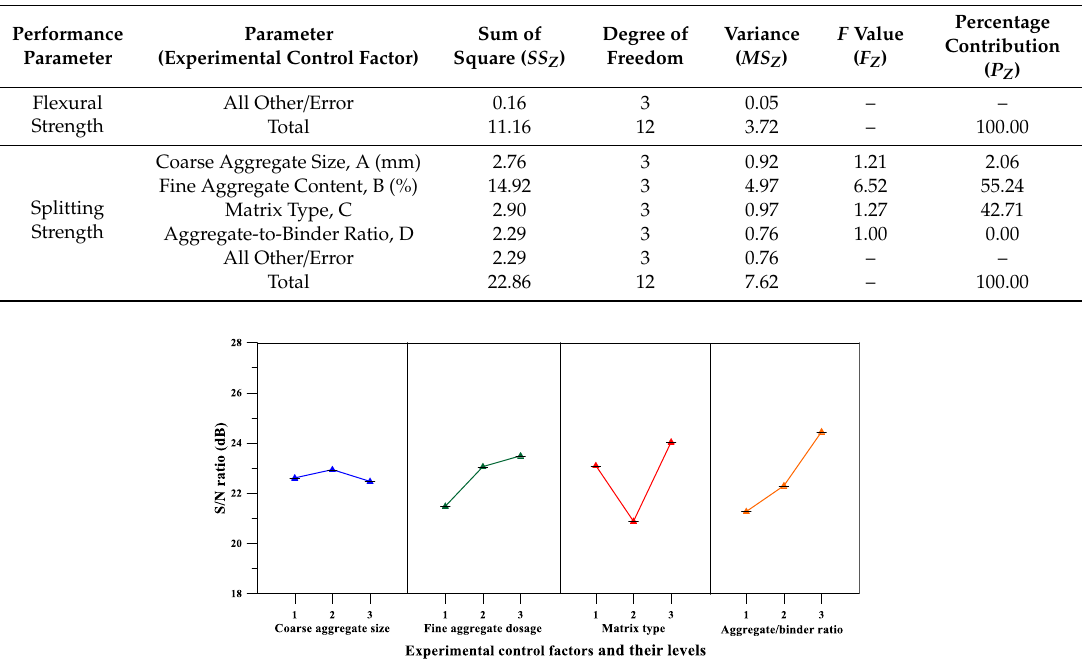
Figure 9. S / N response graph for the compressive strength of pervious concretes.